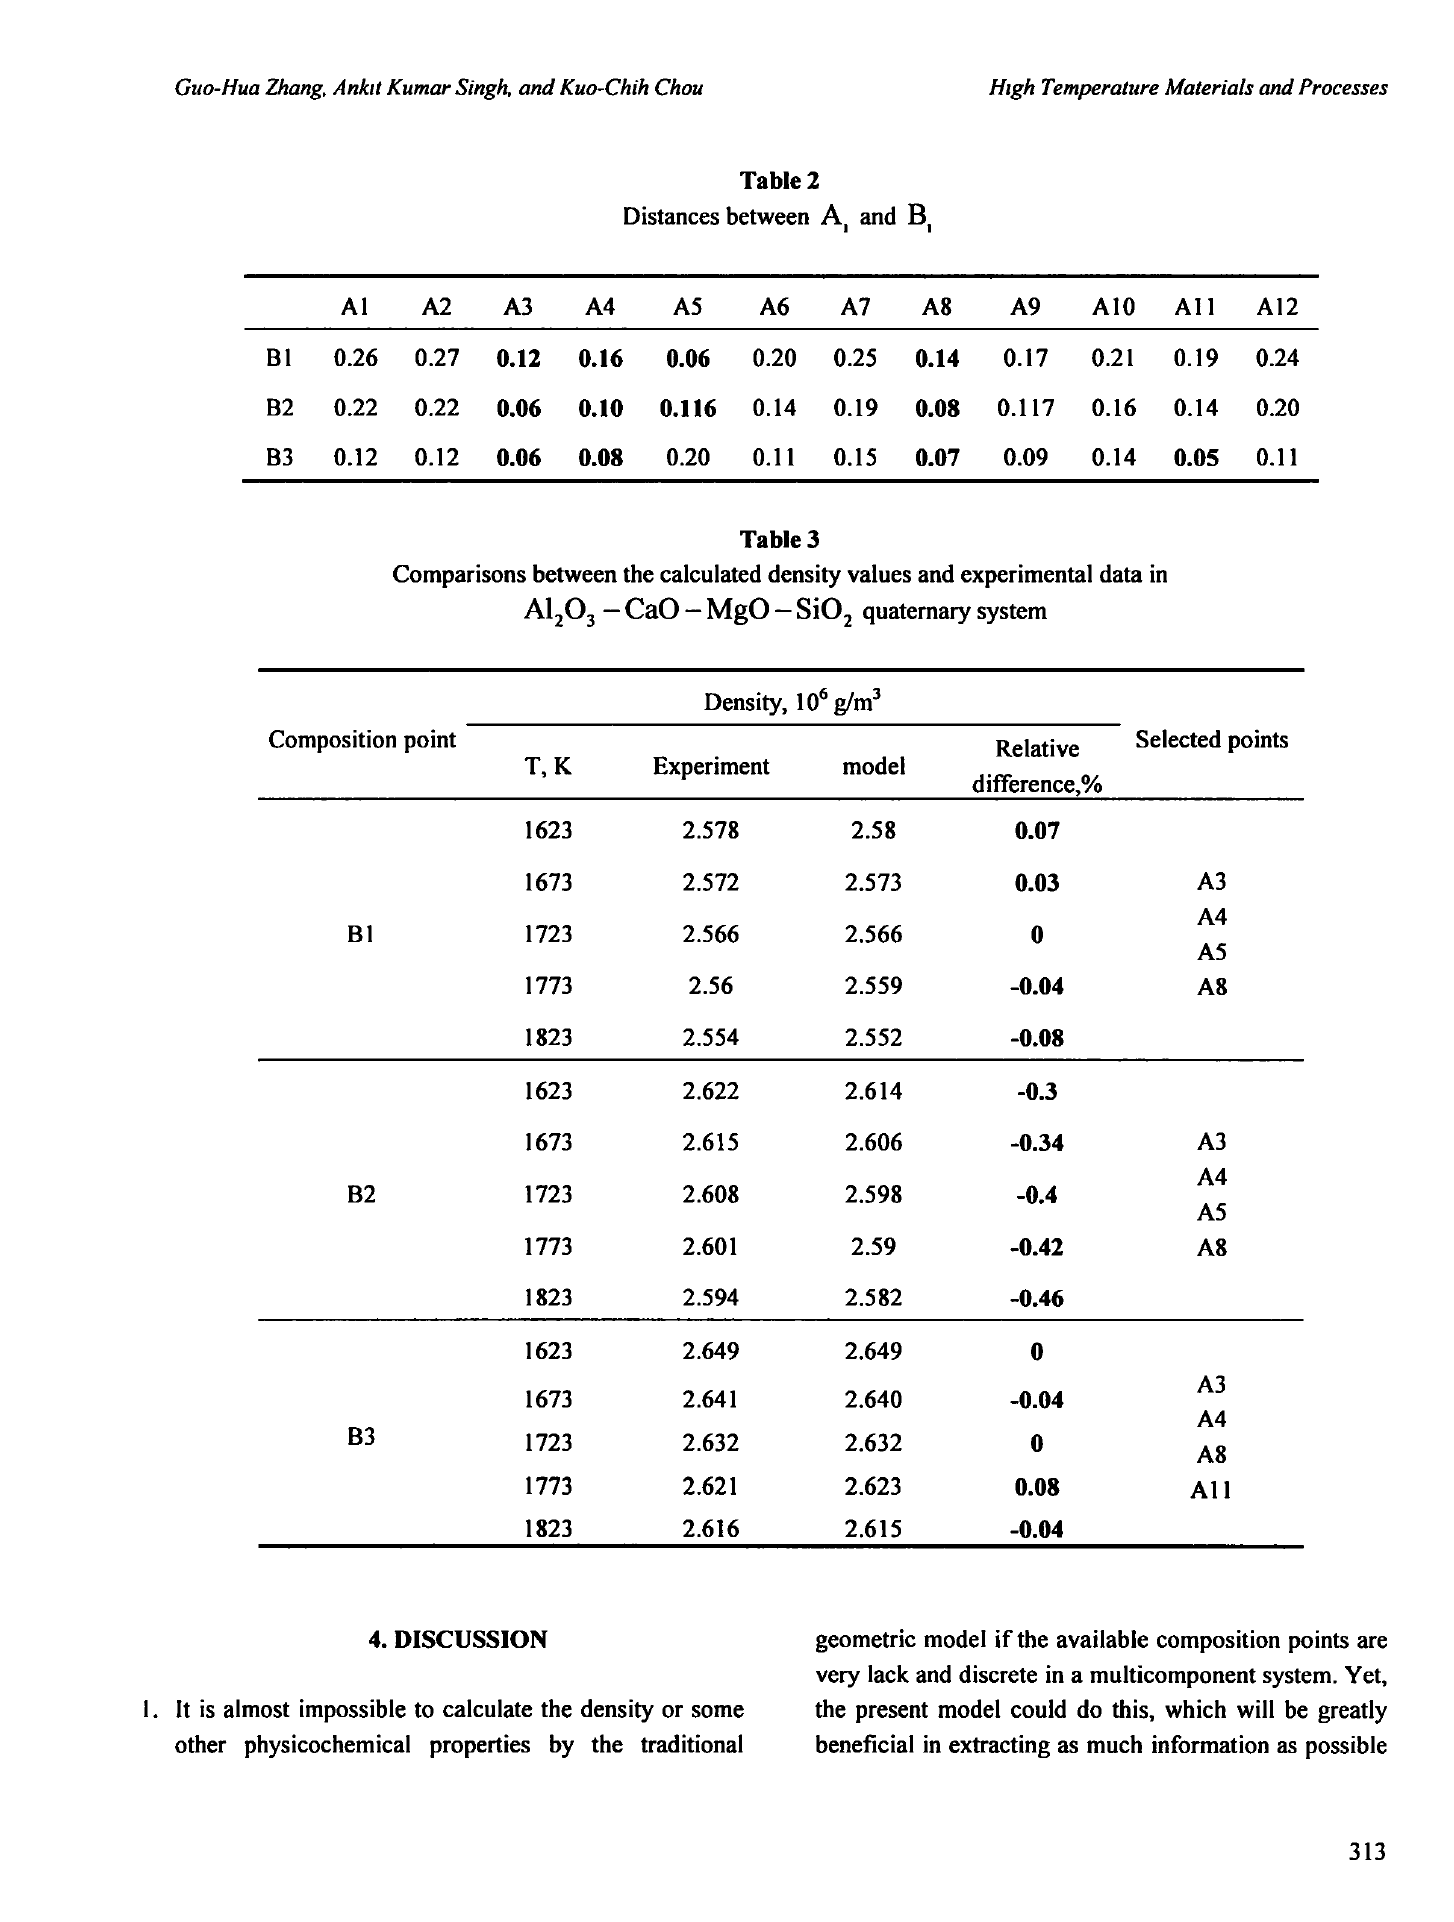
Comparisons between the calculated density values and experimental data